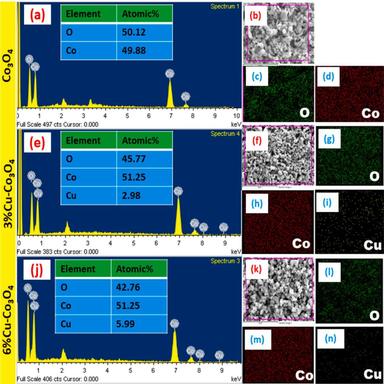
The EDS spectrum with a table including the atomic percentage (at. %) of Co3O4 (a), 3%Cu–Co3O4 (e), and 6%Cu–Co3O4 (j). FESEM-EDS elemental mapping of Co3O4 (b–d), 3%Cu–Co3O4 (f–i), and 6%Cu–Co3O4 (k–n).